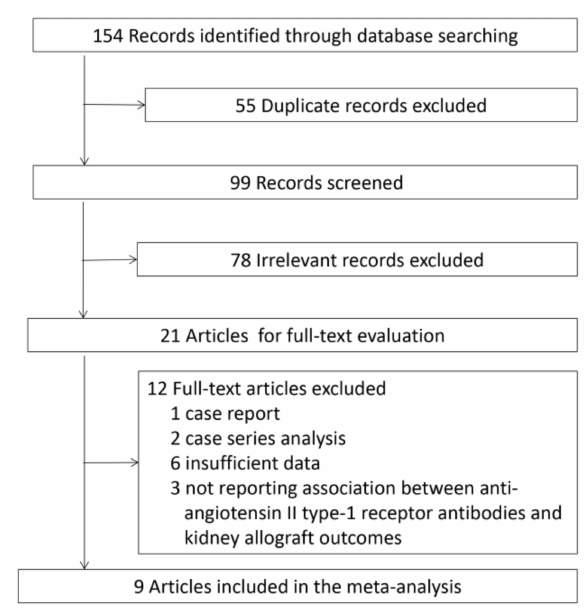
Figure 1. Flowchart showing the study selection